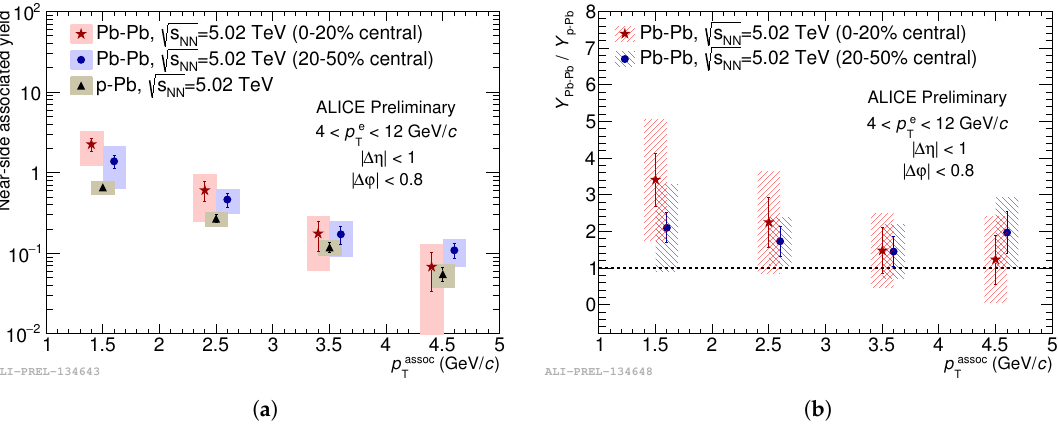
√ s NN = 5.02 TeV. ( b ) Ratio of √ s NN = 5.02 TeV to that of p-Pb collisions with same